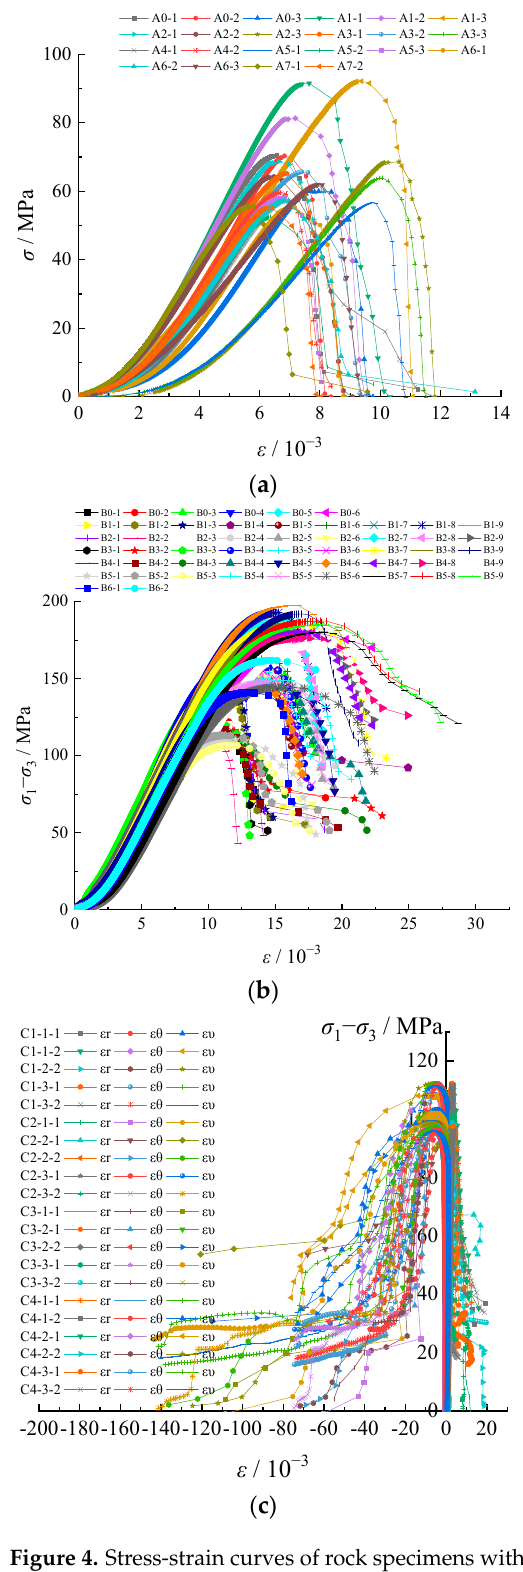
Figure 4. Stress-strain curves of rock specimens with different water content in uniaxial compression tests. ( a ) Uniaxial compression test. ( b ) The conventional triaxial compression test. ( c ) A constant axial pressure and an unloading confining pressure.